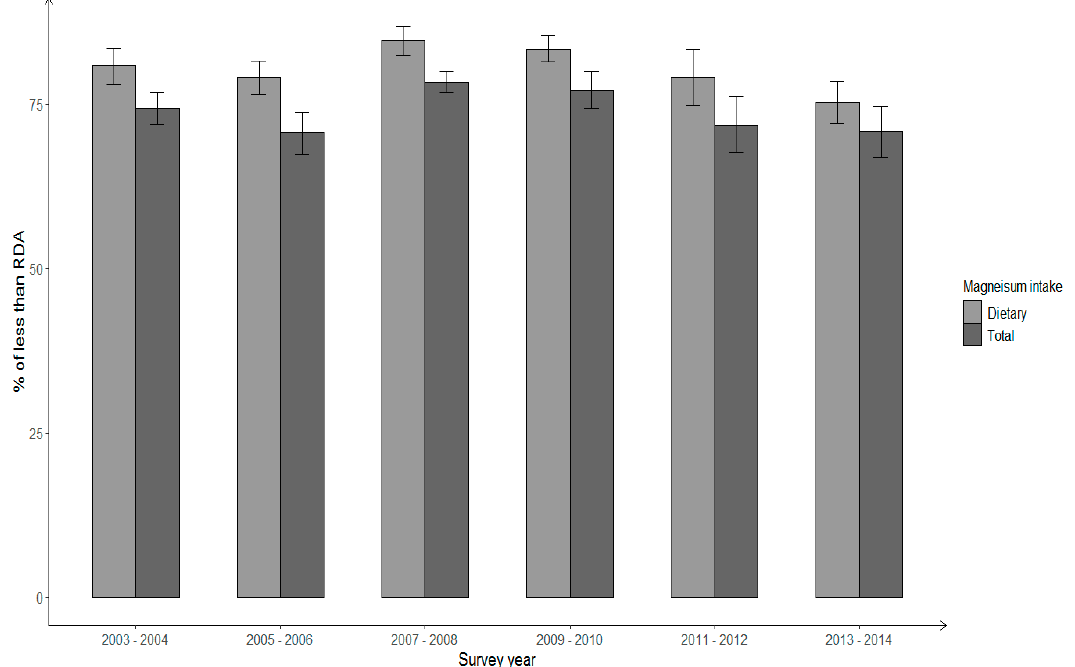
Figure 3. Percentage of insufficient dietary and total magnesium intake among Hispanic females aged ≥ 20 years across NHANES survey years 2003–2014.